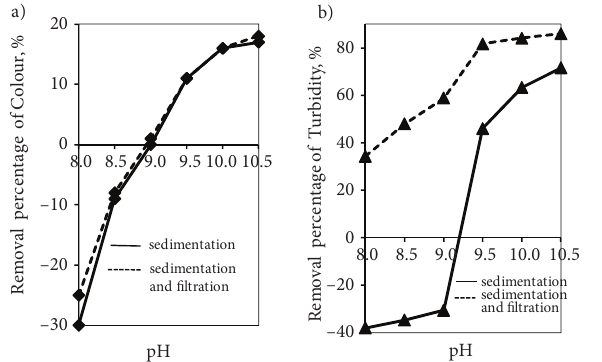
Figure 2. Influence of pH on the efficiency of reduction of TOC, DOC (a) and total iron (b) in the process of Ca(OH) 2 alkalinisation and two-hour